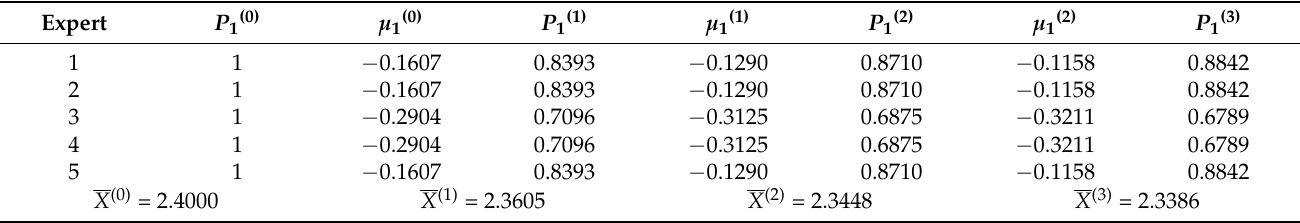
Table 7. Correction of water inrush.